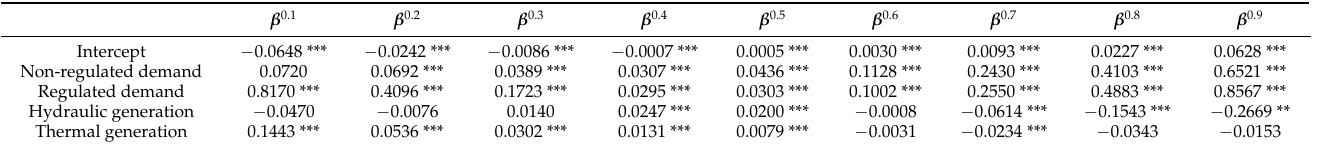
Figure A2. Non-regulated and regulated demand, and hydraulic and thermal generation effects on the electricity spot price for different percentiles and for February–September 2020. The variables are defined as follows: ( a ) effects of the non-regulated demand; ( b ) effects of the regulated demand; ( c ) effects of the hydraulic generation; ( d ) effects of the thermal generation. Table A5. Quantile regression coefficients for the added explanatory variables.